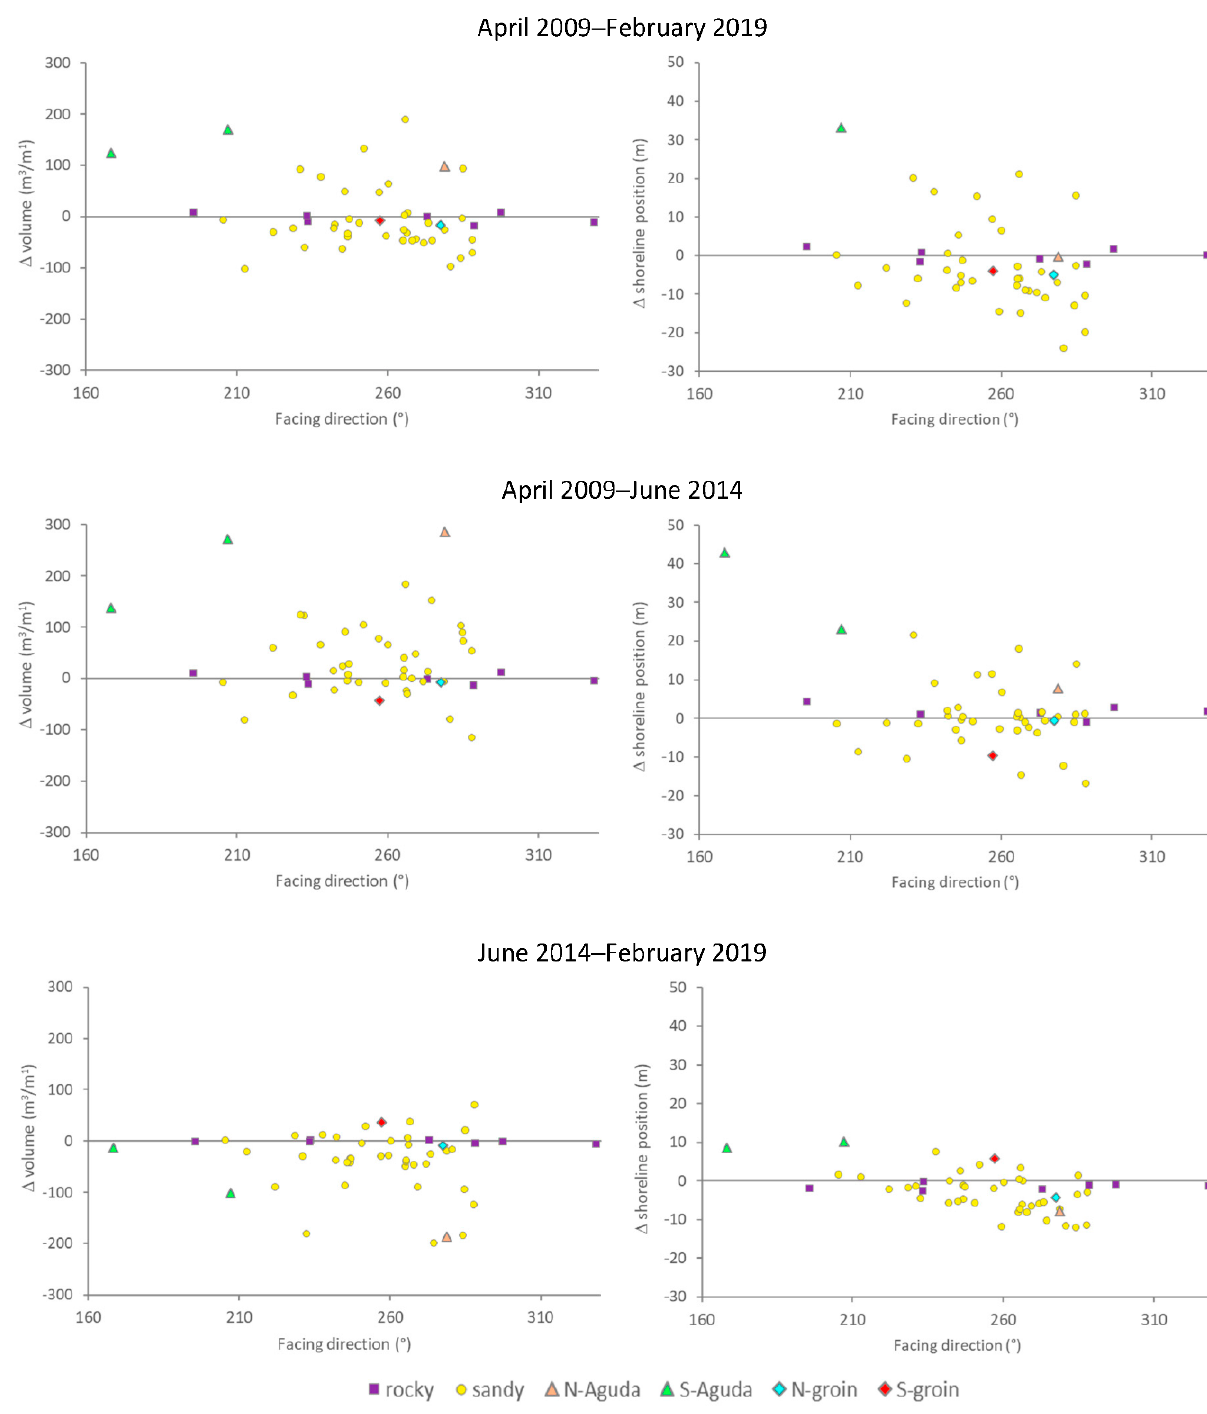
Figure 12. Decadal and 5-yearly changes in volume and shoreline position per segment presented according to segment orientation and marked according to the segment type or its location (N-Aguda: segment 40 north of the Aguda breakwater, S-Aguda: segments 43 and 44 south of the Aguda breakwater, N-groyne: segment 13 north of the groyne, S-groyne: segment 15 south of the groyne).